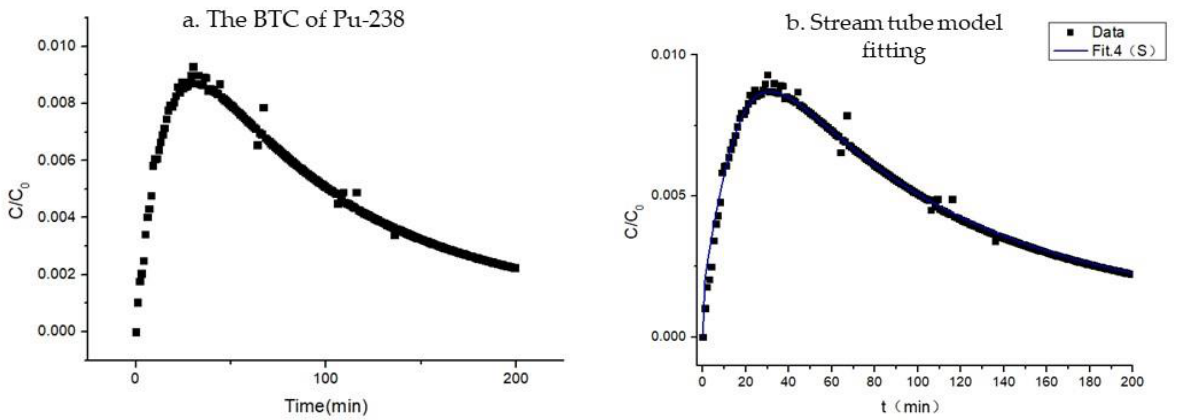
Figure 4. The experimental breakthroughs of Pu-238 and fitting curves.